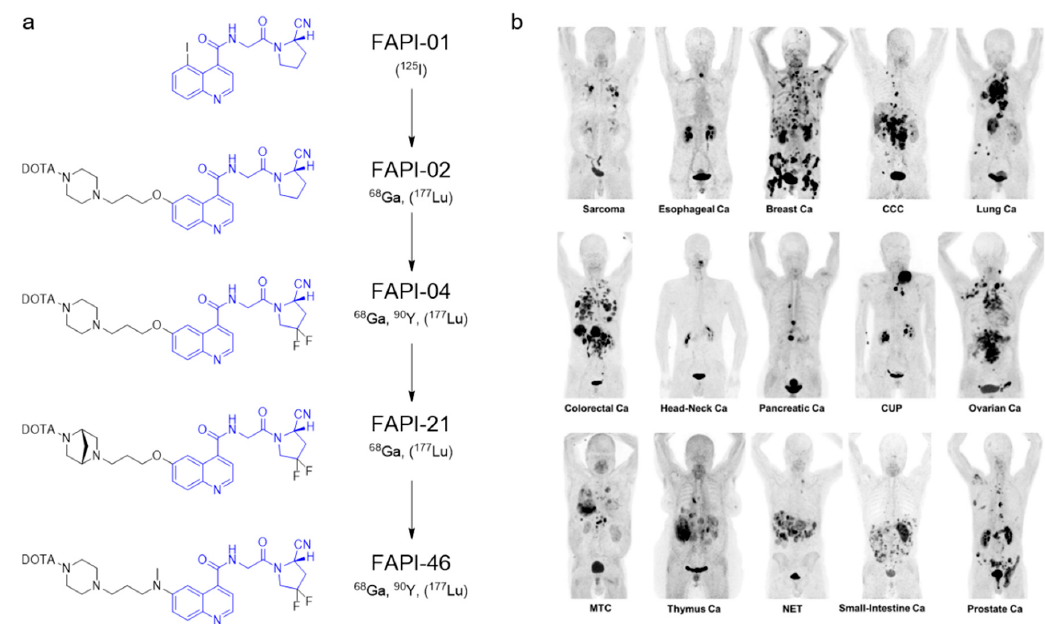
Figure 6. Fibroblast activation protein imaging. ( a ) Chemical structures of FAP-targeted radiopharmaceuticals, which were investigated in detail preclinically and/or clinically. Radionuclides in parentheses were used for preclinical studies. The compounds share a common binding motif (in blue). Figure reproduced with permission from EJNMMI Radiopharm. Chem. 2019 , 4:16 [53], under a Creative Commons Attribution 4.0 International License. ( b ) Maximum-intensity projection (MIP) images of [ 68 Ga]Ga-FAPI-04 PET/CT in patients reflecting 15 different histologically proven tumor entities. Ca = cancer; CCC = cholangiocellular carcinoma; CUP = carcinoma of unknown primary; MTC = medullary thyroid cancer; NET = neuroendocrine tumor. Figure reproduced with permission from J. Nucl. Med. 2019 , 60(6): 801–805 [54]. Copyright 2019 Society of Nuclear Medicine